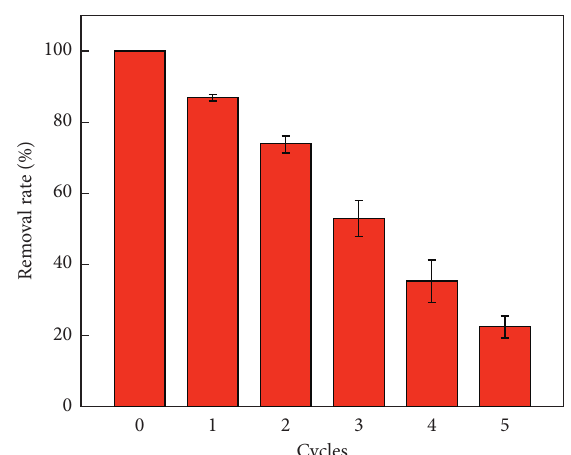
Figure 6: Effect of recycling times on the performance of CBZ removal.